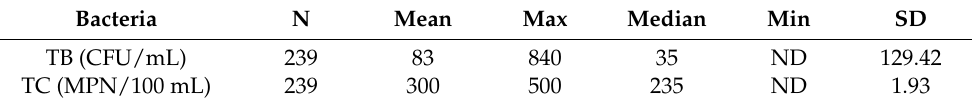
Table 3. Descriptive bacterial contamination statistics for the Xincang River Basin.